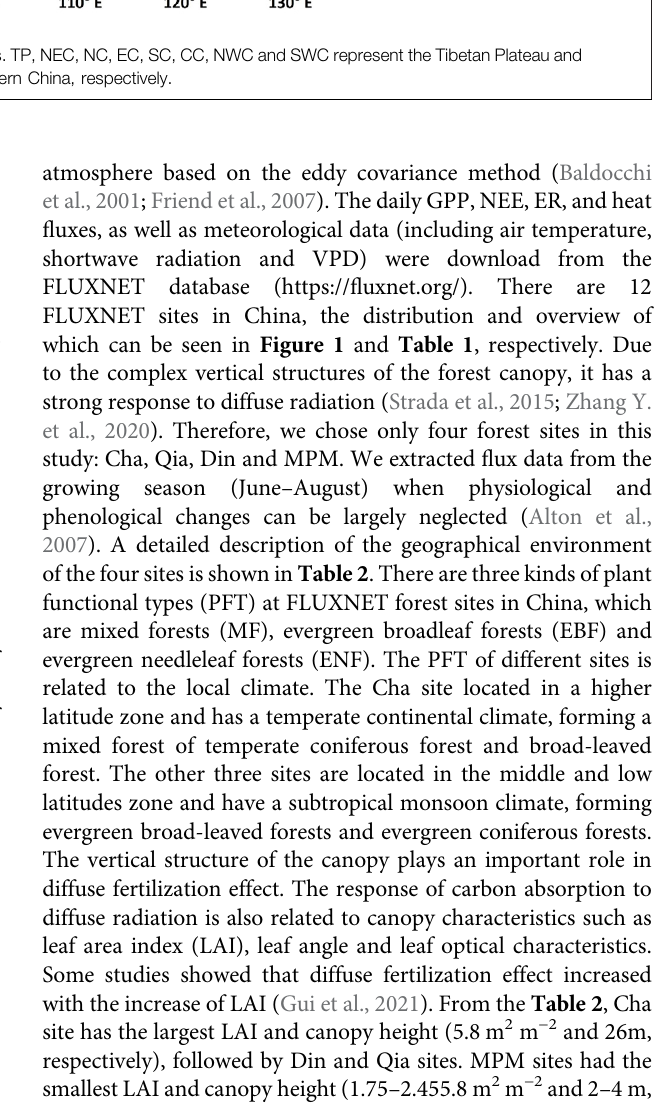
Frontiers in Earth Science |